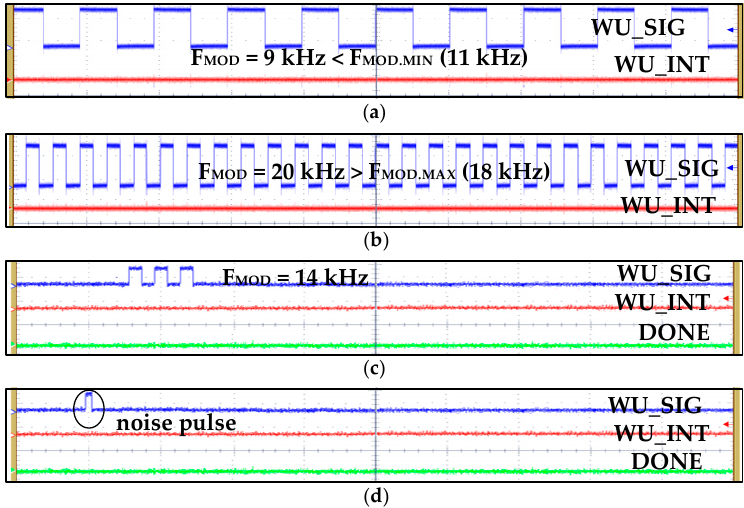
Figure 16. WuRx measurement results for different IDC wake-up modes with valid signals: ( a ) wake-up interrupt (WU-I); ( b ) wake-up monitoring (WU-M); ( c ) self-test with WU-I mode.